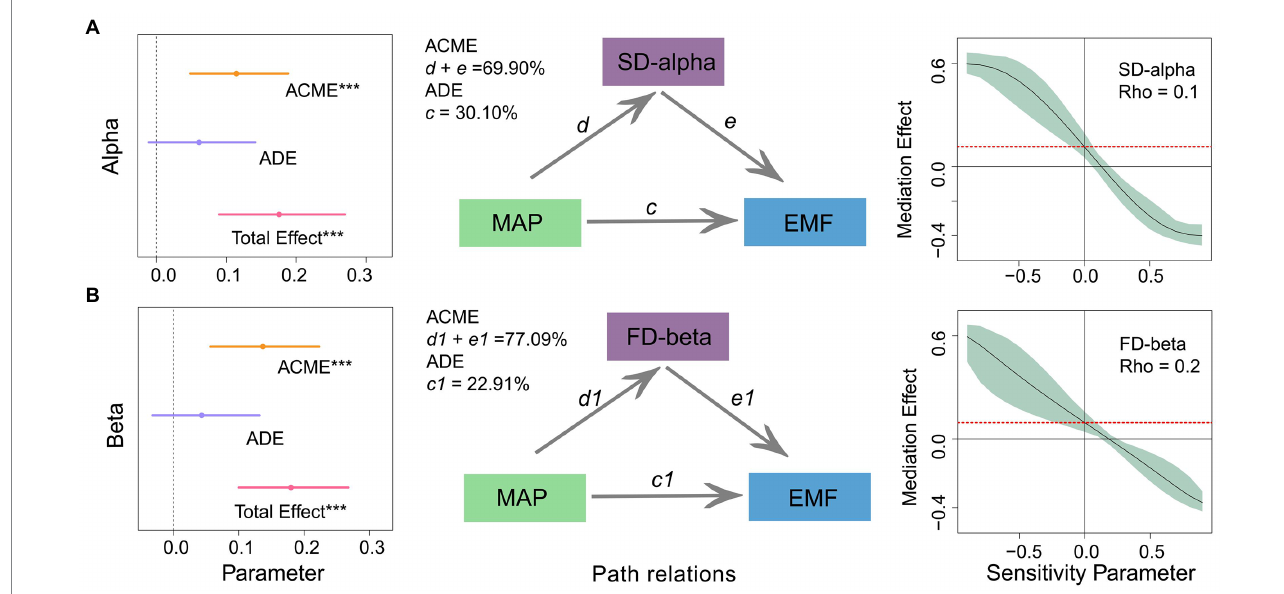
FIGURE 2 Direct and indirect effects of mean annual precipitation (MAP) and diversity at different scales on multifunctionality. The inset on the left indicates the standardized regression coefficients of the mediation model. The middle inset shows the path relationship of the mediating effects. The inset on the right shows the validation of the sensitivity analysis. See Supplementary Table S6 for the standardized regression coefficients for each predictor variable. ACME, average causal mediation effect; ADE, average direct effects; Total Effect, the sum of the average causal mediation and direct effects. (A) alpha diversity; (B) beta diversity.